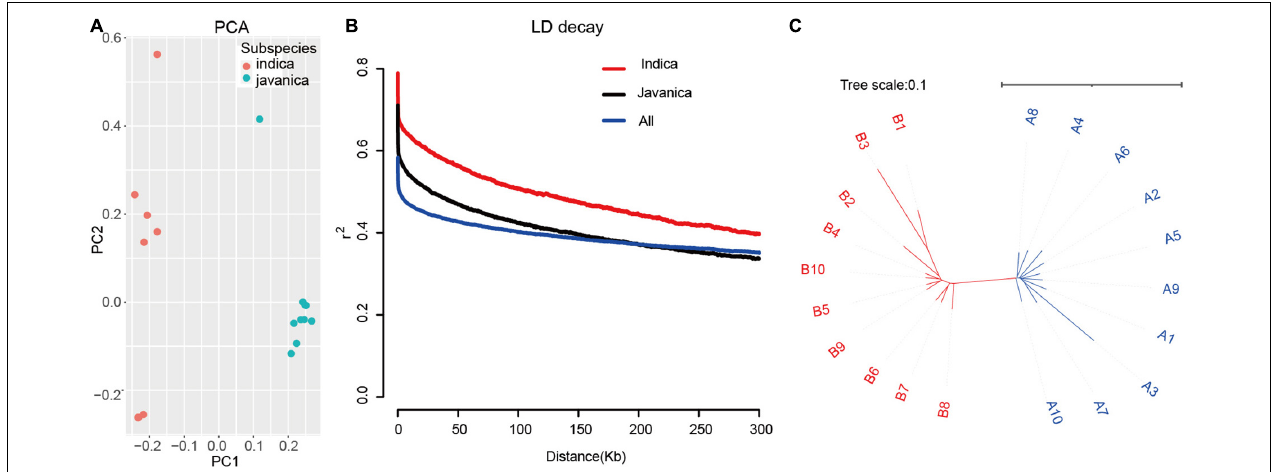
FIGURE 3 | Population structure of the 20 rice varieties. (A) PCA of 20 rice accessions. Colors red and green indicate indica and javanica, respectively. (B) Decay of LD expressed as r 2 as a function of inter-SNP distance for filtered MBML-intersect SNP, in the indica, javanica, and whole 20 population. (C) Unweighted neighbor-joining tree for genome-wide SNP, horizontal bar indicates distance by simple matching